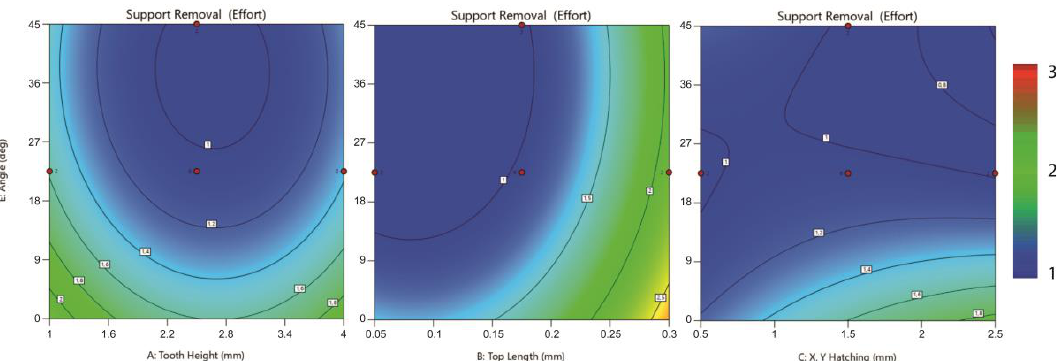
Figure 9. Contour plots of support parameters and Overhang Angle on Support Removal Effort. Table 7. Fit statistics of Warping